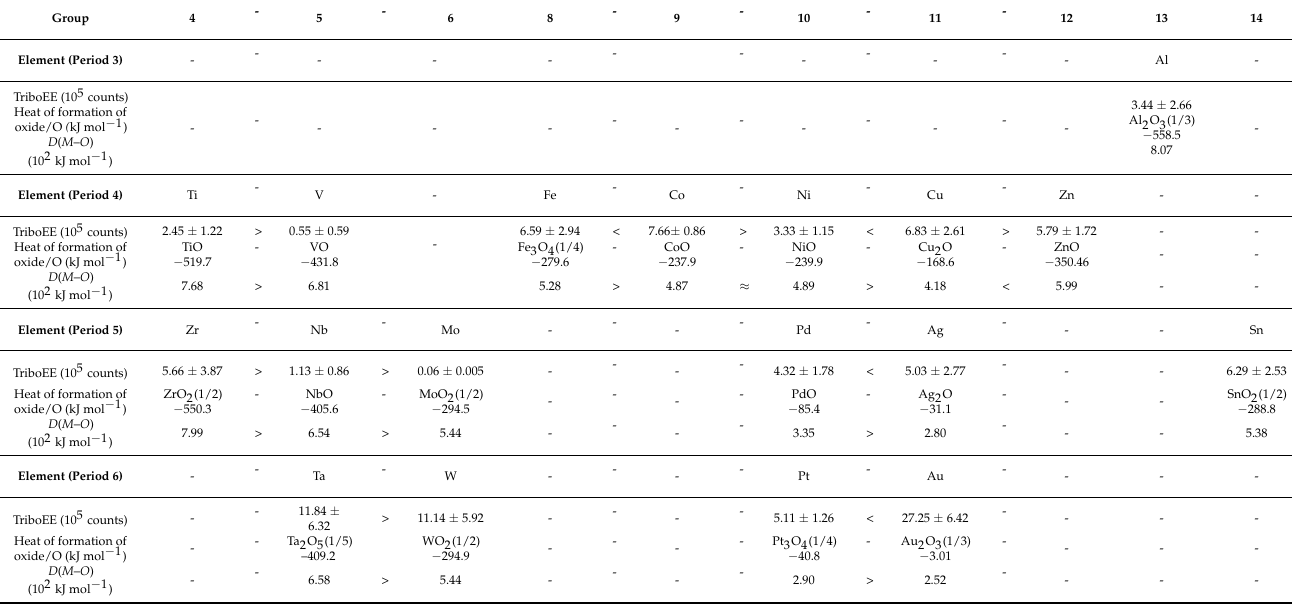
Figure 4. The change in intensity (cpm: counts/min) of TriboEE with rubbing time for groups 13 (Al), 12 (Zn), and 14 (Sn), giving the median value of TriboEE intensity. Table 1. The relationship between TriboEE intensity (the average and STDEV values) 1 and the heat of formation of metal oxides per oxygen atom, and the metal–oxygen bond energies, D ( M – O ), between the metals and oxygen 2